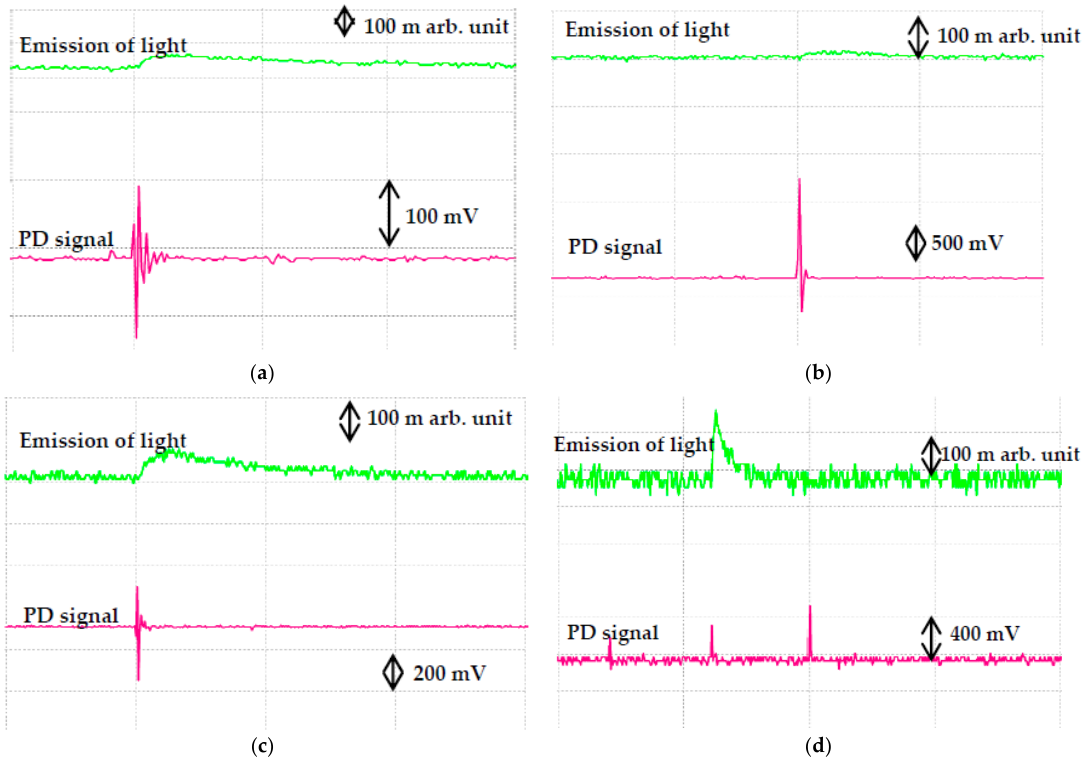
Figure 11. Emission of light signals (PMT) and PD signals (IMC) for ( a ) RBDPOA, ( b ) RBDPOB, ( c ) CO and ( d ) MO based Al 2 O 3 without SDS at 30 kV applied voltage.